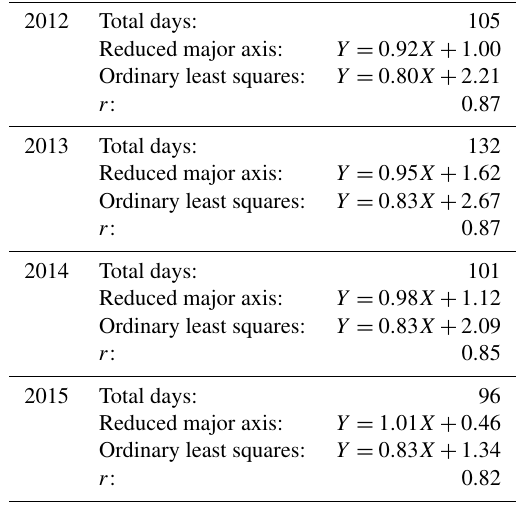
Table 4. Same as Table 3 but for the warm season (April–October) over eastern China.